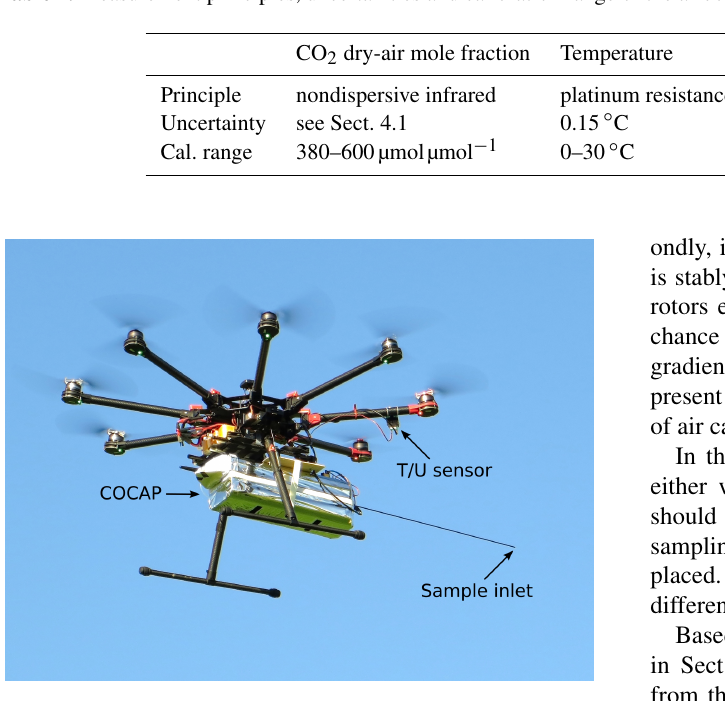
Figure 3. COCAP was carried by a multicopter during the ScaleX 2016 campaign. The positions of the sample inlet for the CO 2 measurement and of the temperature and humidity sensor board are